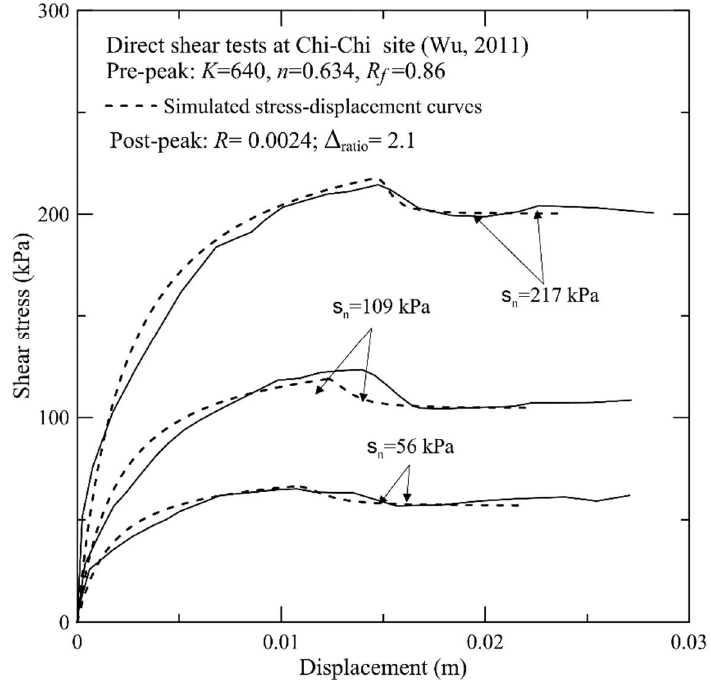
Figure 6. Comparison of calculated and experimental stress-displacement curves reported by Wu (2011).